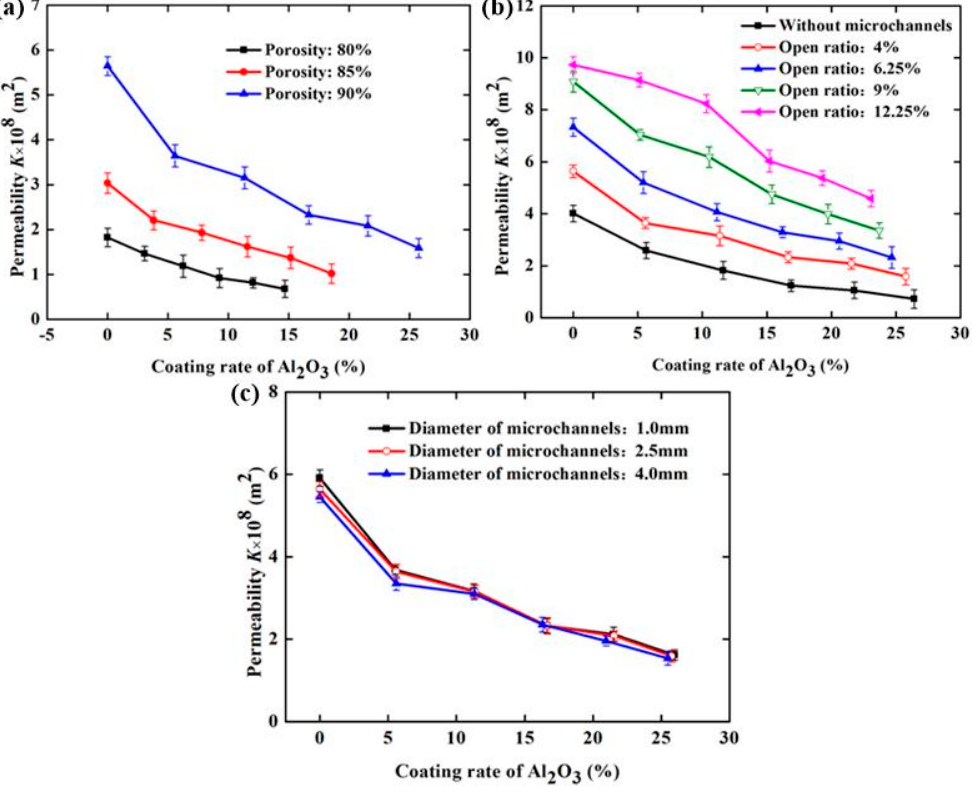
Figure 11. Permeability of SCSSFFC/Al 2 O 3 with different Al 2 O 3 coating rates under different structure parameters of SCSSFFC: ( a ) porosity ( α = 4%, d = 2.5 mm); ( b ) open ratio ( ε = 90%, d = 2.5 mm); ( c ) diameter of microchannel ( ε = 90%, α = 4%).